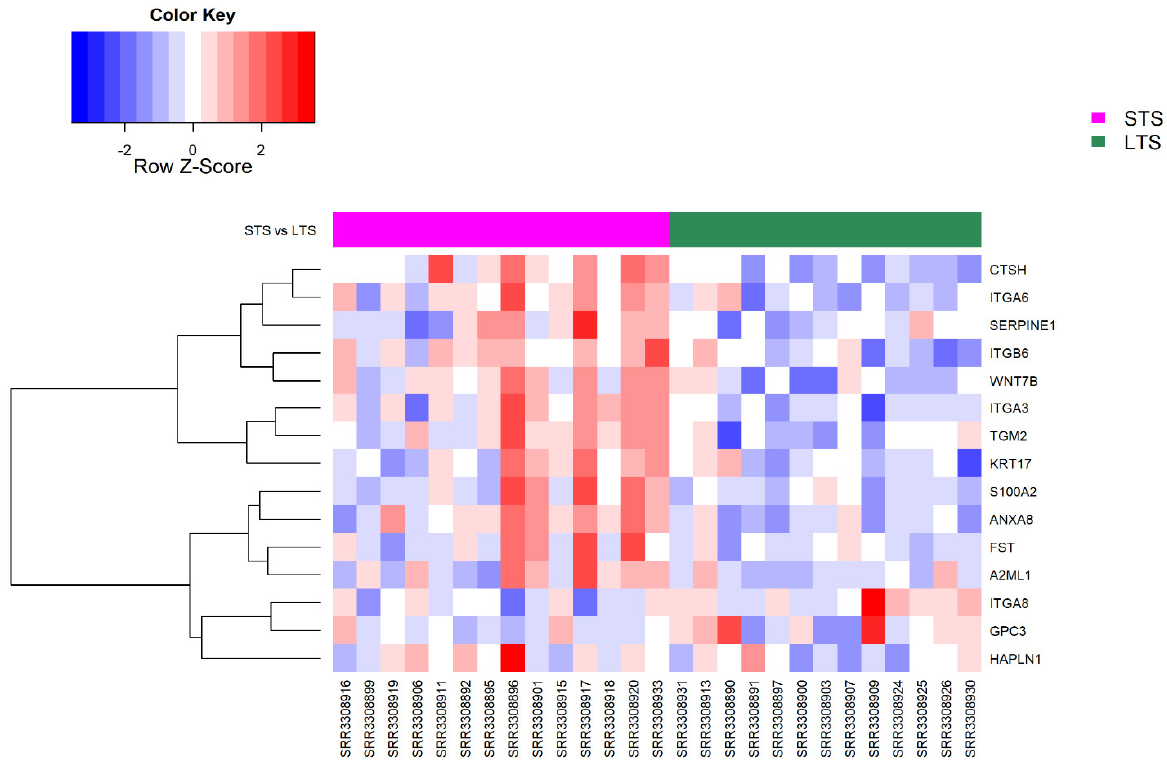
Figure 5. Heatmap and dendrogram showing the normalised expression levels of ECM-related genes ( n = 15) that were differentially expressed in PDAC stroma–epithelium, as well as in short- and long-term PDAC survivors (STS and LTS, respectively), from the dataset GSE79668 (FDR < 0.05). The number of samples from STS and LTS subjects are 14 and 13, respectively. Red and blue colours indicate increased and decreased expression, respectively.